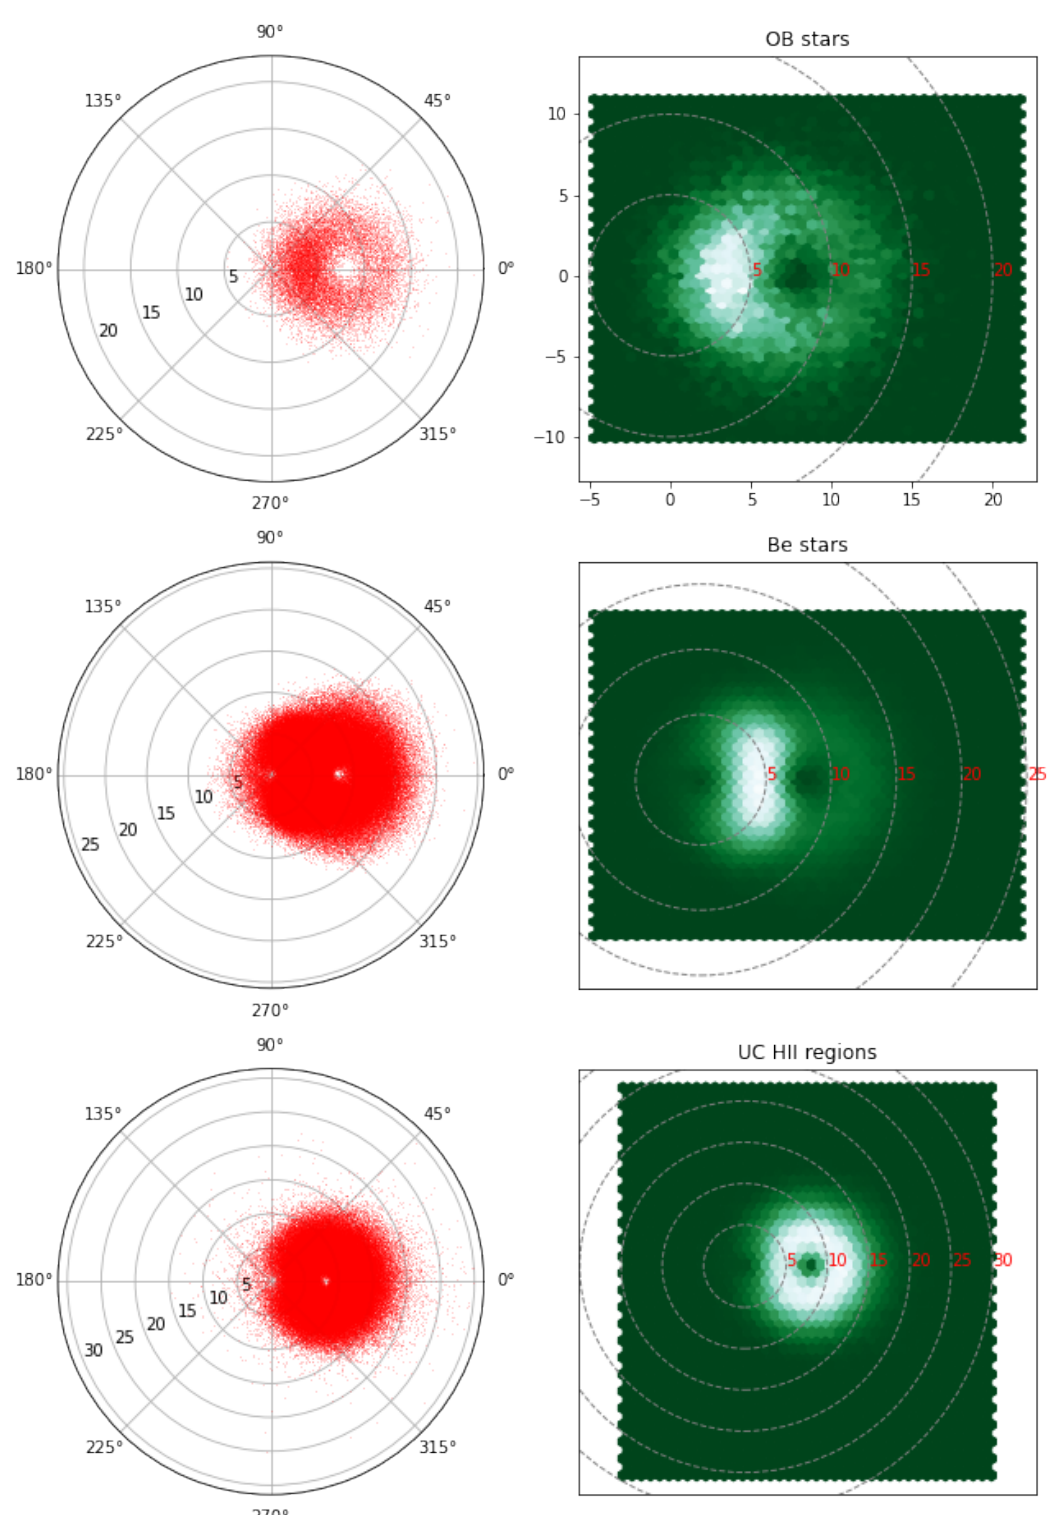
Figure 11. The space distribution of detectable (above 10 nano-Jy in 8 h integration) OB, Be stars, and UC HII regions along the galactic plane. The first column is the source distribution in polar coordinates center at the sun. The radius represent distance to the sun in kpc. The second column is the kernel density distribution of the